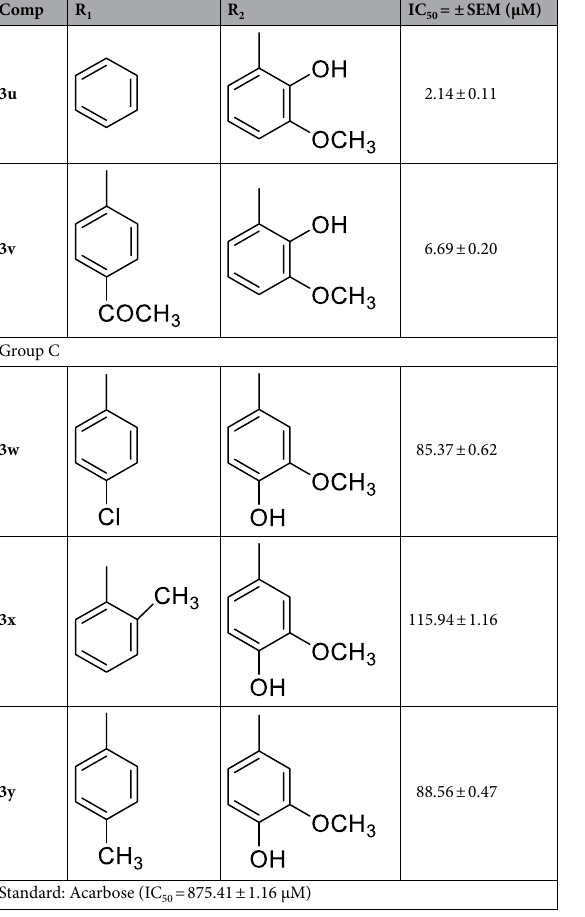
Table 1. In vitro α -glucosidase inhibition of different substituents of Schiff bases of 1,3-diphenyl urea